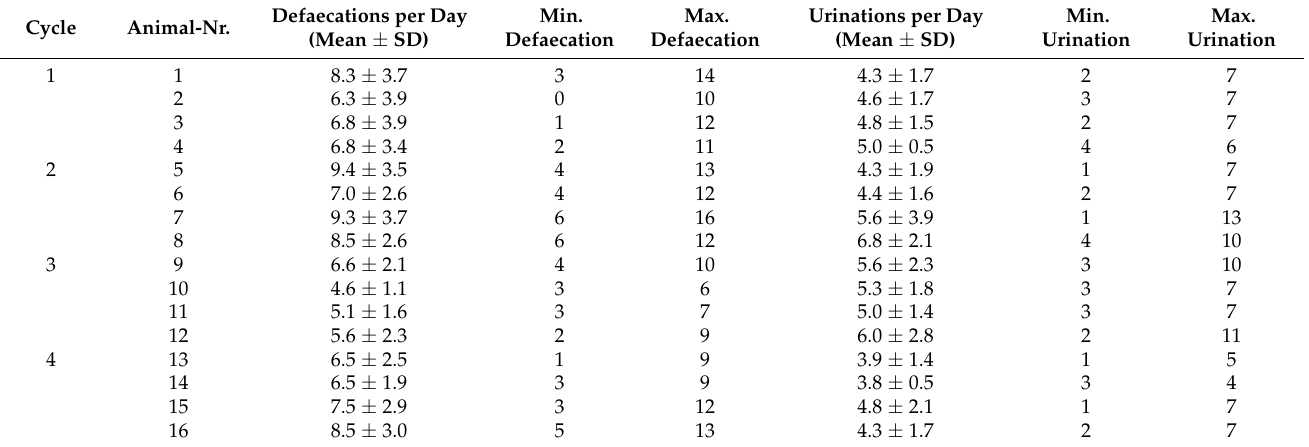
Table 3. Number of defaecations/urinations per day for all individuals in different experimental cycles (means, standard deviations, minimum and maximum) obtained by video analysis.